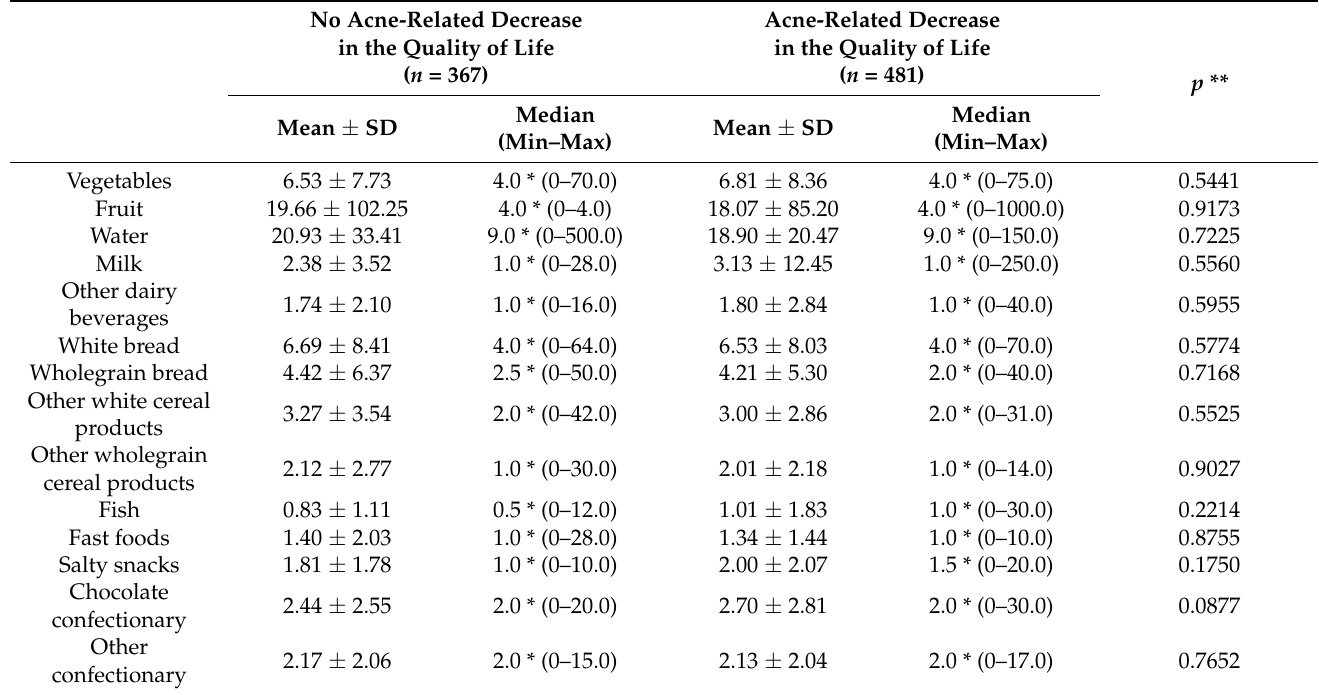
Table 6. The comparison of the consumption of food items within the Acne-specific Food Frequency Questionnaire (Acne-FFQ) in subgroups stratified by the acne-related quality of life, assessed based on the Acne Quality of Life (AQoL) Scale in the group of Polish female adolescents participating in the